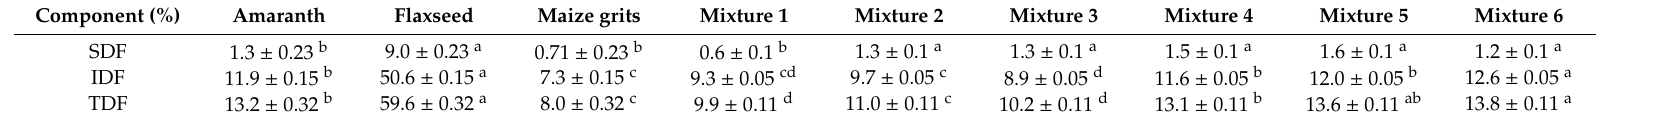
Table 3. Dietary fiber content of the raw materials and the mixtures without extruding